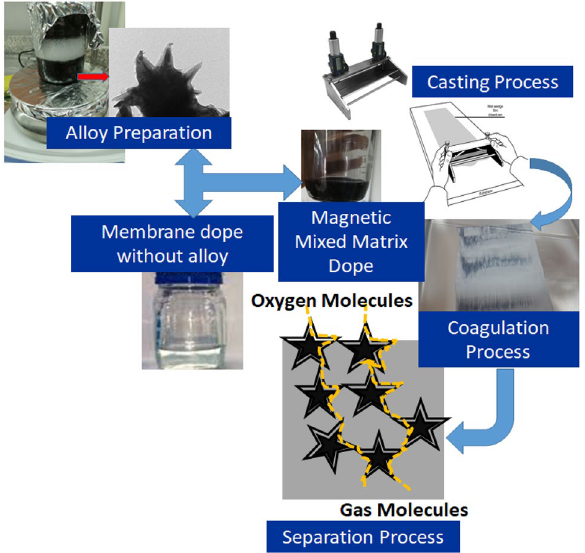
Figure 2. A schematic representation of the preparation procedure of both the fillers; for example, Fe 10 Ni 90 alloy, and the mixed matrix poly(ethersulfone) (PES) membranes.